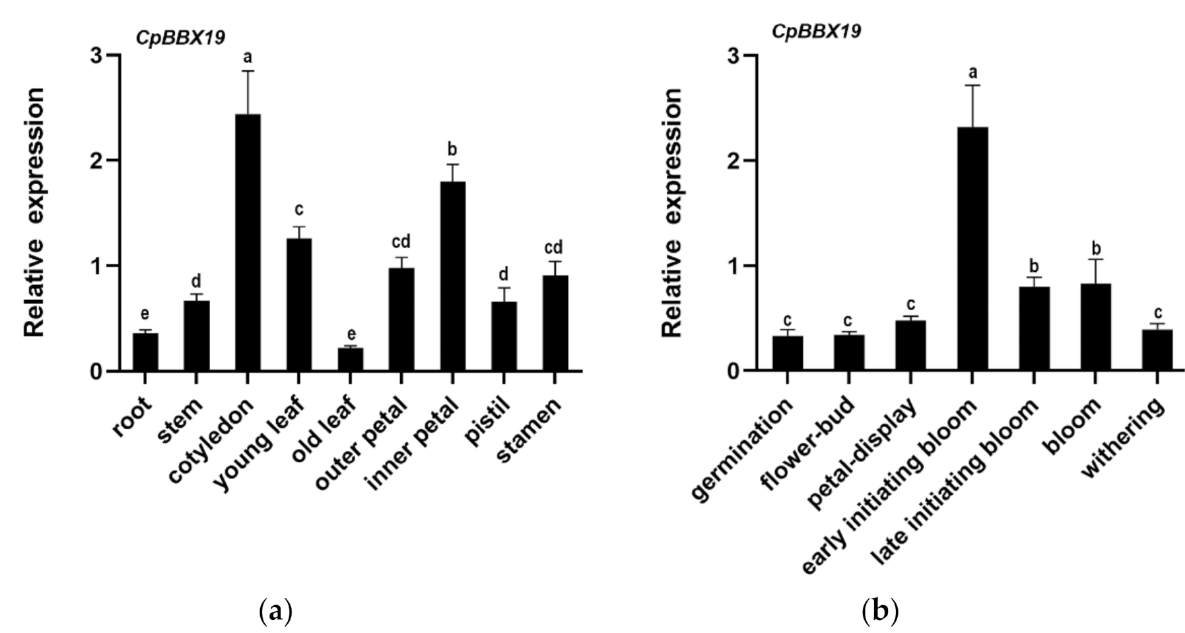
Figure 3. Expression pattern analysis of CpBBX19 in wintersweet by qRT-PCR. ( a ) Expression of CpBBX19 in different tissues of wintersweet. ( b ) Expression of CpBBX19 in different floral development stages of wintersweet. CpActin was used as the internal reference gene. Data represent the mean of three biological repeats ± SD. Error bars indicate standard deviation. Different lowercase letters (a–e, cd) on bars indicate significant differences ( p <